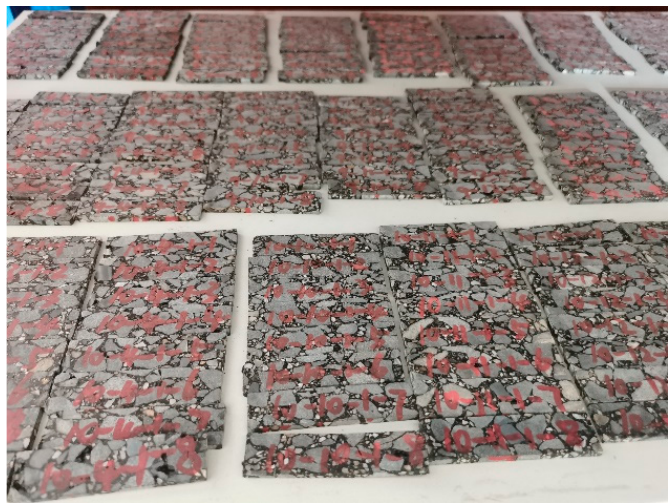
Figure 3. DMA specimen.